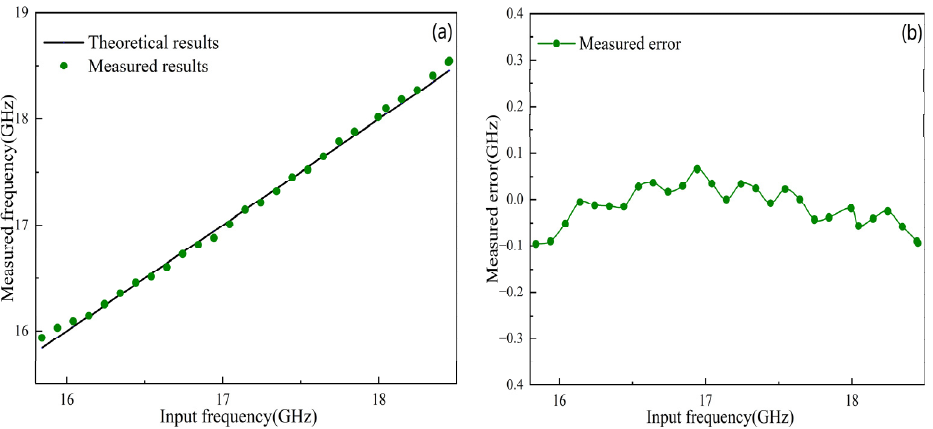
Figure 5. ( a ) Theoretical and measured results of frequency measurements. ( b ) measurement error.